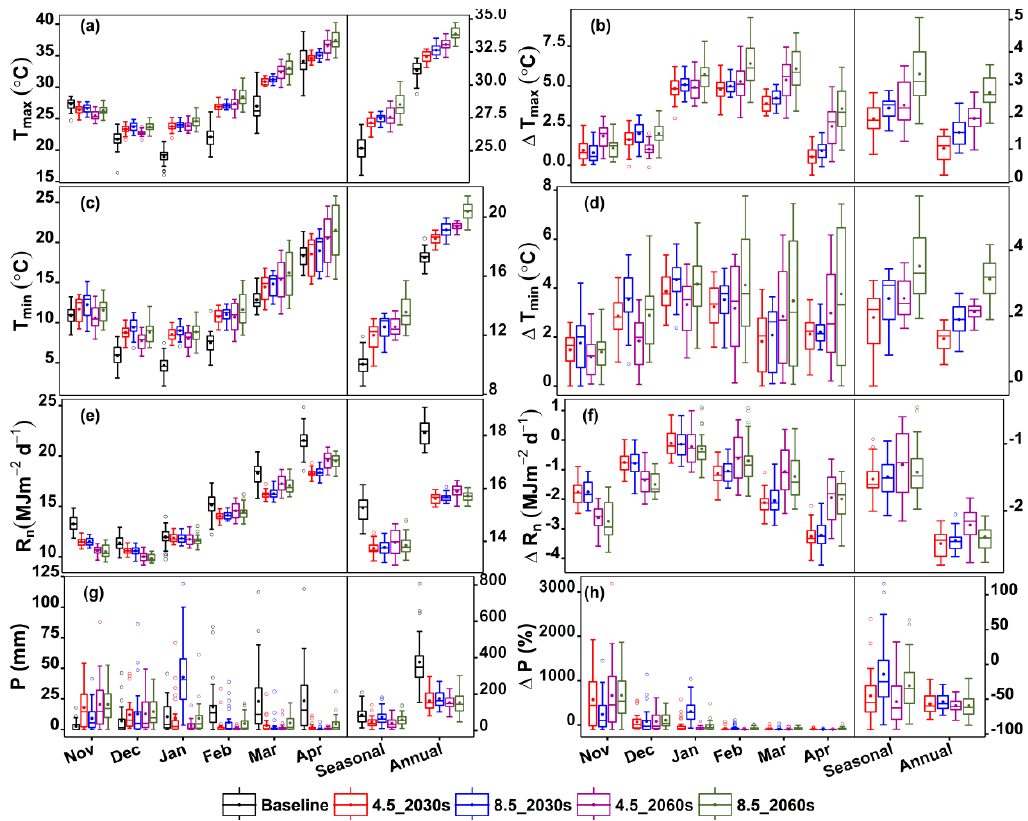
Figure 6. Monthly-, seasonal- and annual-scale variability of (a) maximum temperature (T max ), (c) minimum temperature (T min ), (e) solar radiation (R n ) and (g) rainfall (P) during the baseline (1980–2010), the 2030s (2021–2050) and the 2060s (2051–2080). The right-hand panel (Figure 6 b,d,f,h) shows the change of average baseline T max , T min , R n and P during the future time slices. The boxes in Figure 12a–h represent the inter-quartile range (IQR), the whiskers extend up to 1.5 times the IQR, the dots and horizontal lines inside the boxes represent mean and median, respectively, and outliers are shown as hollow dots outside the boxes. Monthly values are plotted on the left y-axes and seasonal and annual values are plotted on the right y-axes.